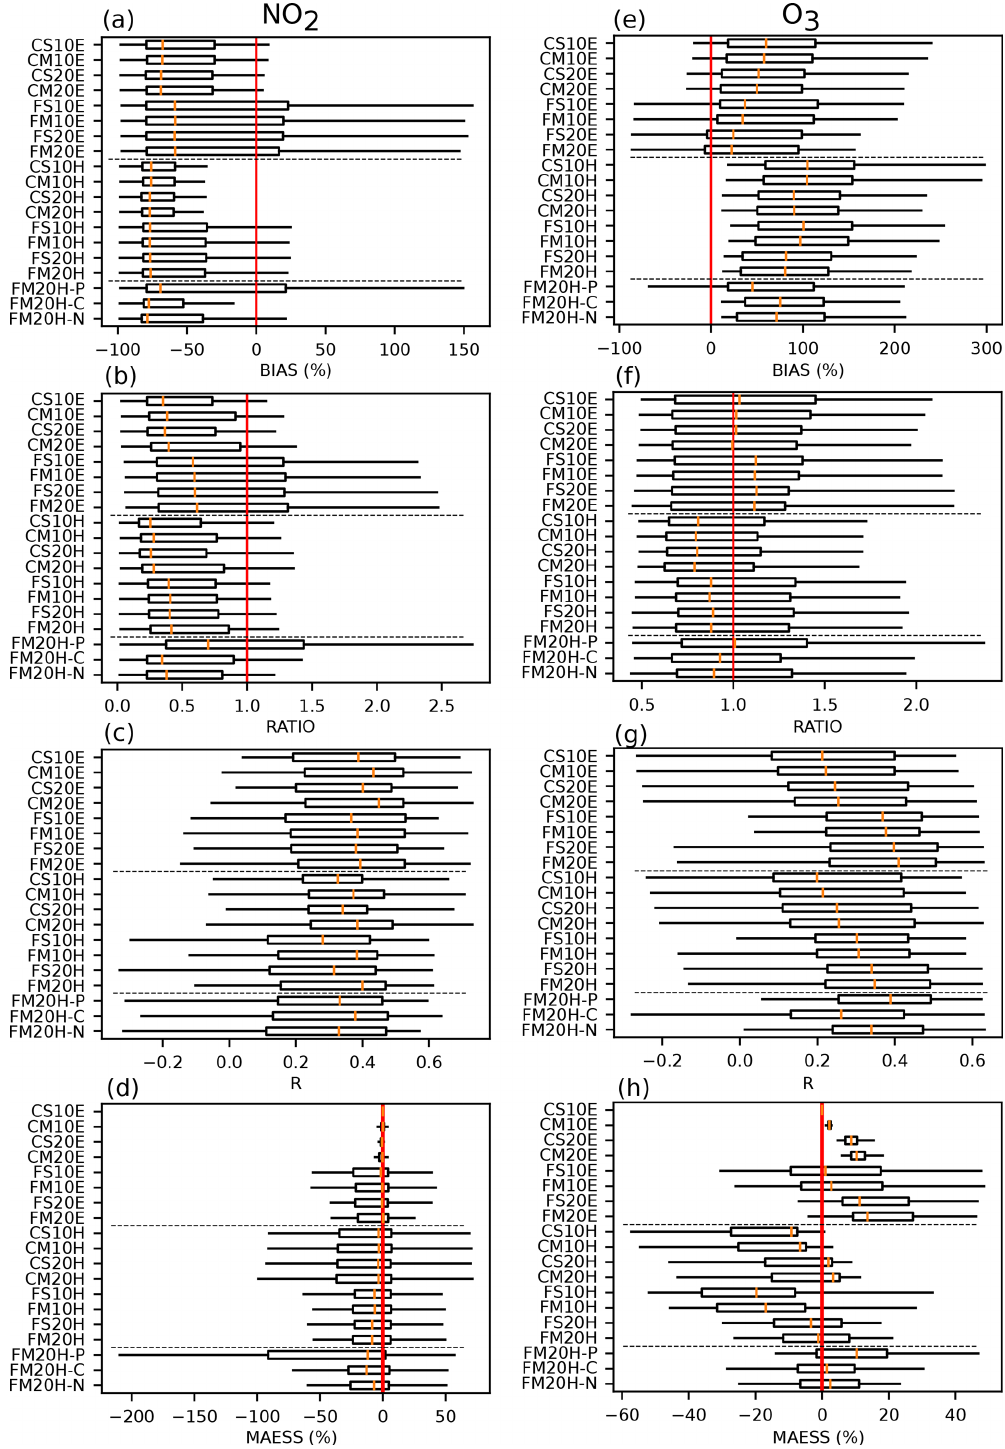
Figure 8. Temporal verification results for daily near-surface minimum NO 2 (a–d) and O 3 (e–h) . (a, e) Percentage bias (BIAS), (b, f) Pearson correlation coefficient ( R ), (c, g) ratio of standard deviation (RATIO), (d, h) mean absolute error skill score (MAESS) with reference to the base experiment CS10E. Box plots are calculated upon the pointwise verification results at all available stations. Experiments are explained and grouped as in Table